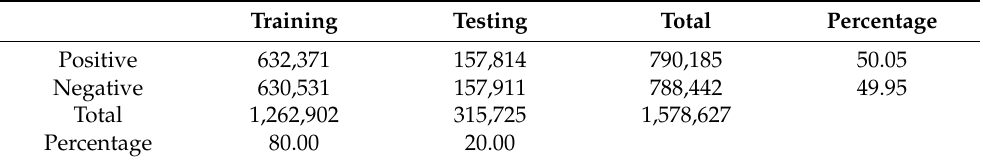
Table 2. Dataset split.